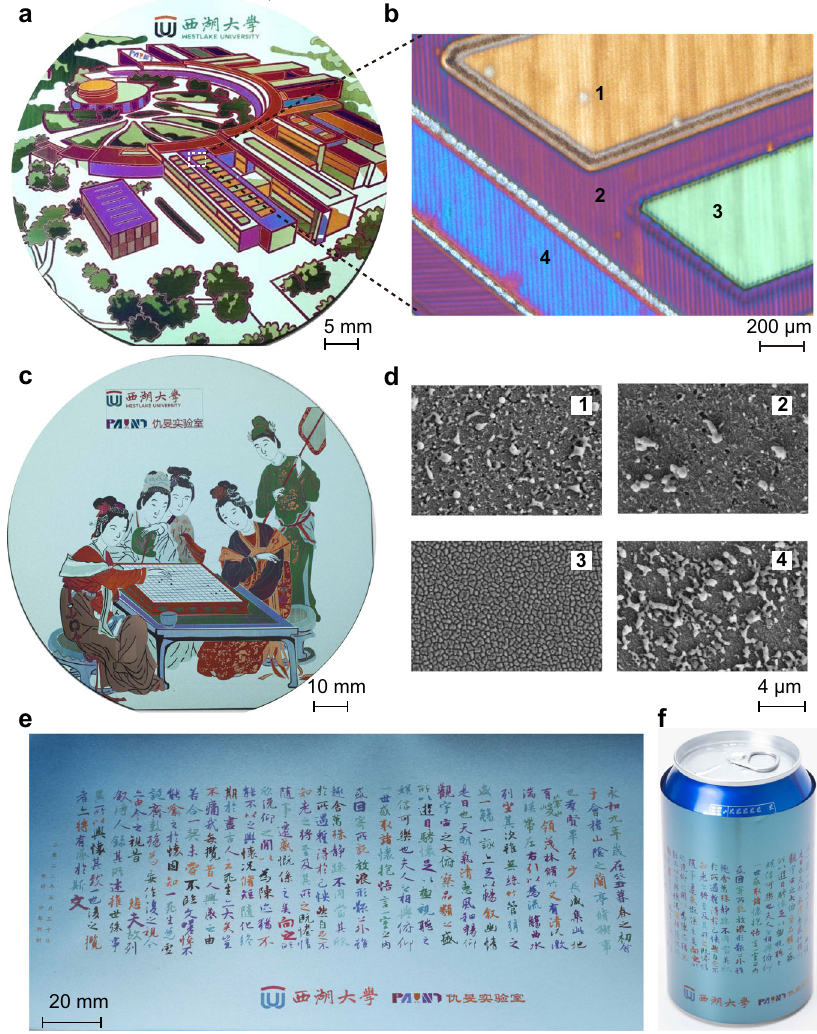
Fig. 5 | Large-scale laser color printing. a Photograph of a structural color-based large-scale pattern ( “ The academic ring of Yungu campus at Westlake university ” , with the permission from Westlake university), which is printed on TiAlN – TiN hybrid fi lms on a polished 2-in. Si wafer. b Optical microscopy image and corre- sponding SEM images in areas ( d , 1 – 4). Photographs of laser-printed large-scale patternsondifferentsubstrates,includingunpolishedbacksideofa4-in.Siwaferin